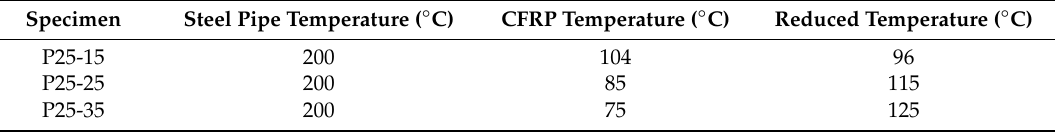
Table 10. The measured CFRP temperatures of di ff erent thickness